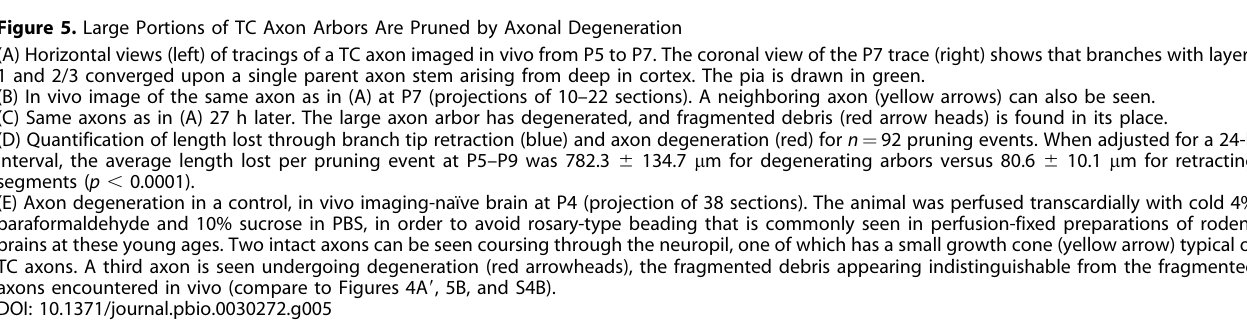
Figure 5. Large Portions of TC Axon Arbors Are Pruned by Axonal Degeneration (A) Horizontal views (left) of tracings of a TC axon imaged in vivo from P5 to P7. The coronal view of the P7 trace (right) shows that branches with layers 1 and 2/3 converged upon a single parent axon stem arising from deep in cortex. The pia is drawn in green. (B) In vivo image of the same axon as in (A) at P7 (projections of 10–22 sections). A neighboring axon (yellow arrows) can also be seen. (C) Same axons as in (A) 27 h later. The large axon arbor has degenerated, and fragmented debris (red arrow heads) is found in its place. (D) Quantification of length lost through branch tip retraction (blue) and axon degeneration (red) for n ¼ 92 pruning events. When adjusted for a 24-h interval, the average length lost per pruning event at P5–P9 was 782.3 6 134.7 l m for degenerating arbors versus 80.6 6 10.1 l m for retracting segments ( p , 0.0001). (E) Axon degeneration in a control, in vivo imaging-naı¨ve brain at P4 (projection of 38 sections). The animal was perfused transcardially with cold 4% paraformaldehyde and 10% sucrose in PBS, in order to avoid rosary-type beading that is commonly seen in perfusion-fixed preparations of rodent brains at these young ages. Two intact axons can be seen coursing through the neuropil, one of which has a small growth cone (yellow arrow) typical of TC axons. A third axon is seen undergoing degeneration (red arrowheads), the fragmented debris appearing indistinguishable from the fragmented axons encountered in vivo (compare to Figures 4A 9 , 5B, and S4B). DOI: